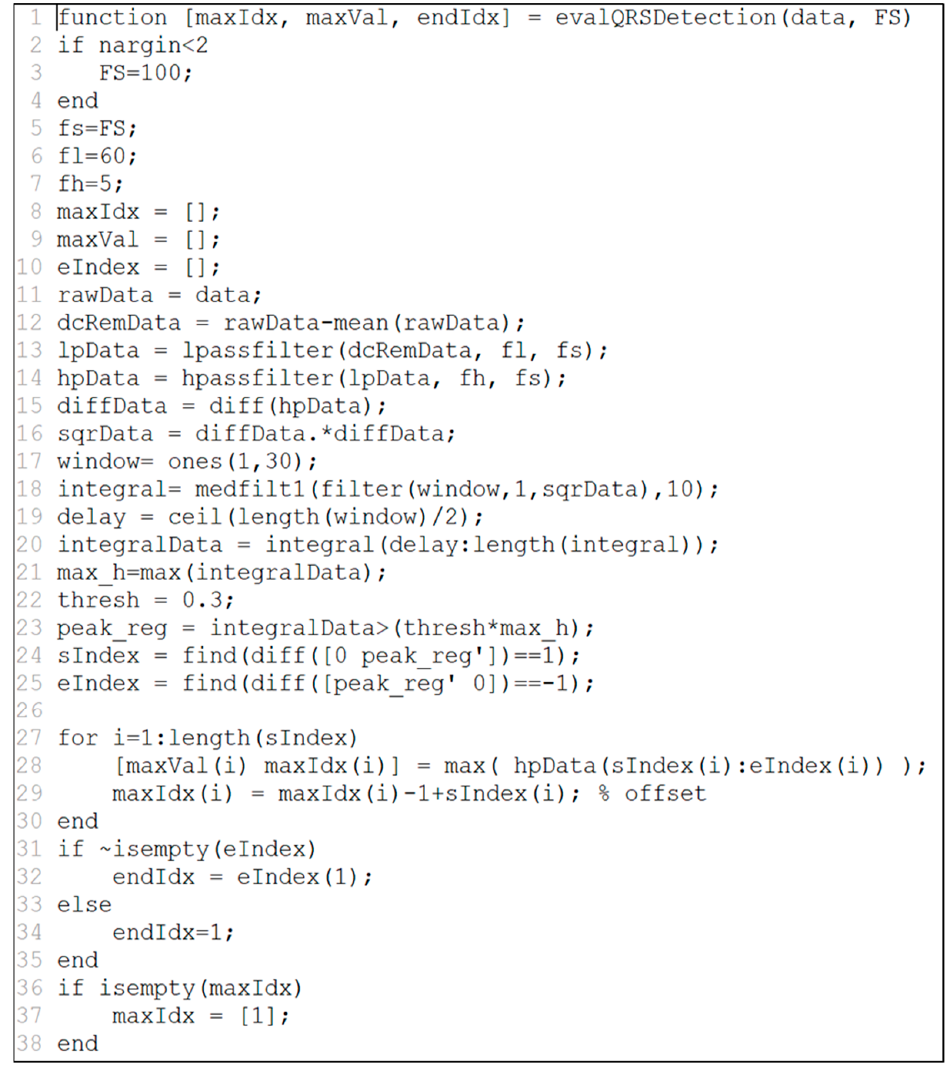
Figure 5. Example of MATLAB source to extract HRV from ECG.